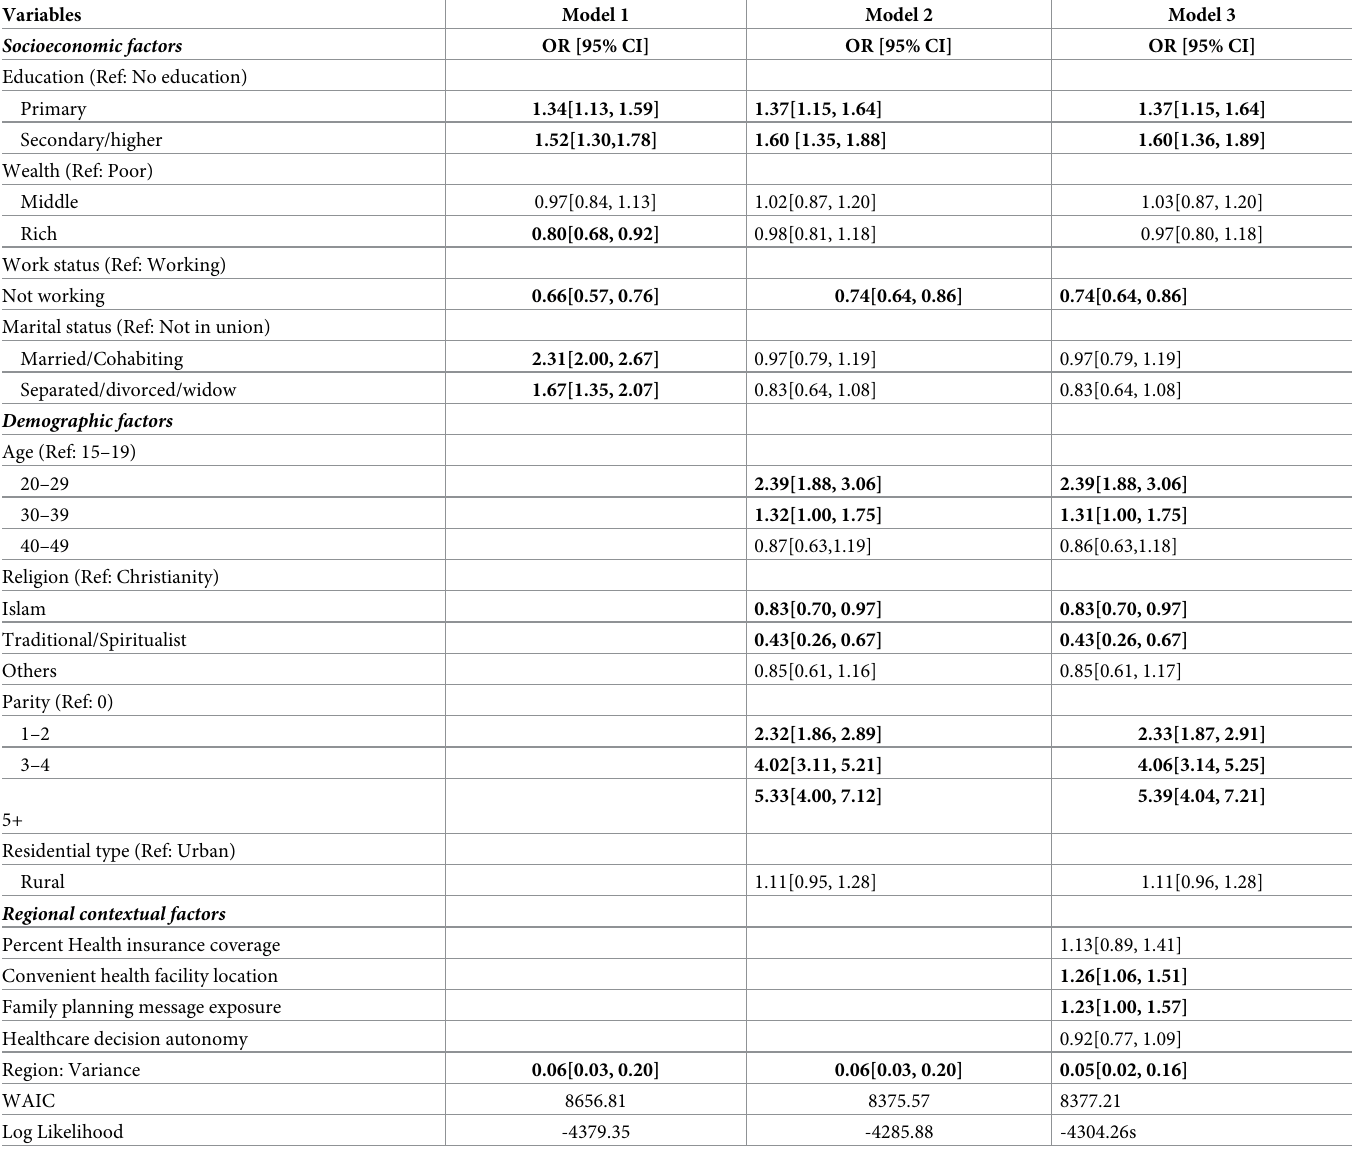
Table 2. Bayesian multilevel logistic regression analysis of modern contraceptive use in Ghana,